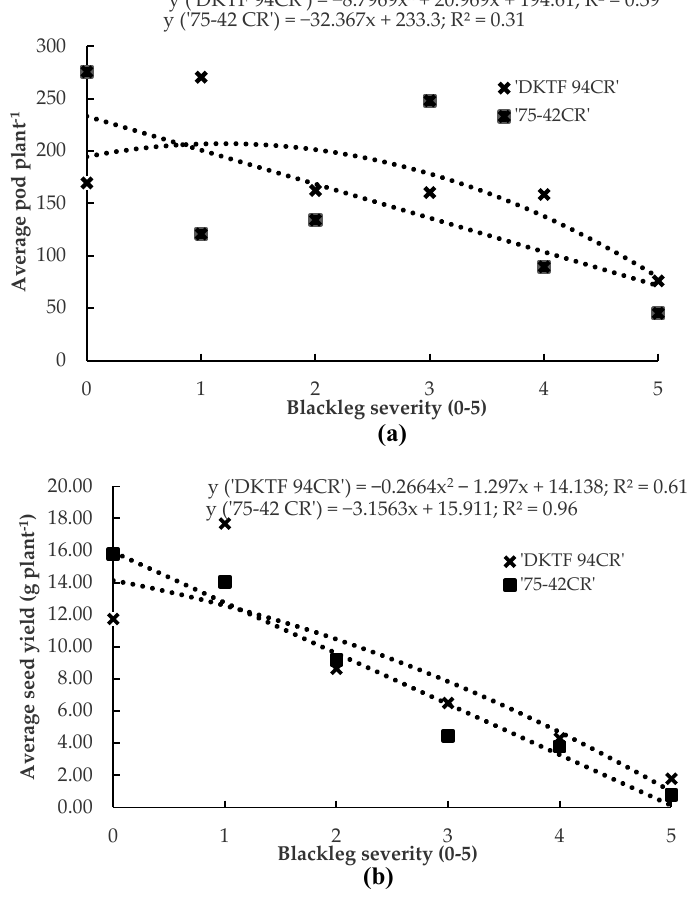
Figure 4. Relationship between blackleg severity and pods per plant ( a ) and seed yield per plant ( b ) in the canola hybrids ‘DKTF 94CR’ and ‘75-42CR’ sampled in 12 commercial fields around Lacombe and Wetaskiwin, AB, Canada, in 2019. Each point represents the mean of all fields planted to the same canola hybrid. Blackleg severity was assessed on a 0–5 scale, where 0 = no disease and 5 = death of the plant.